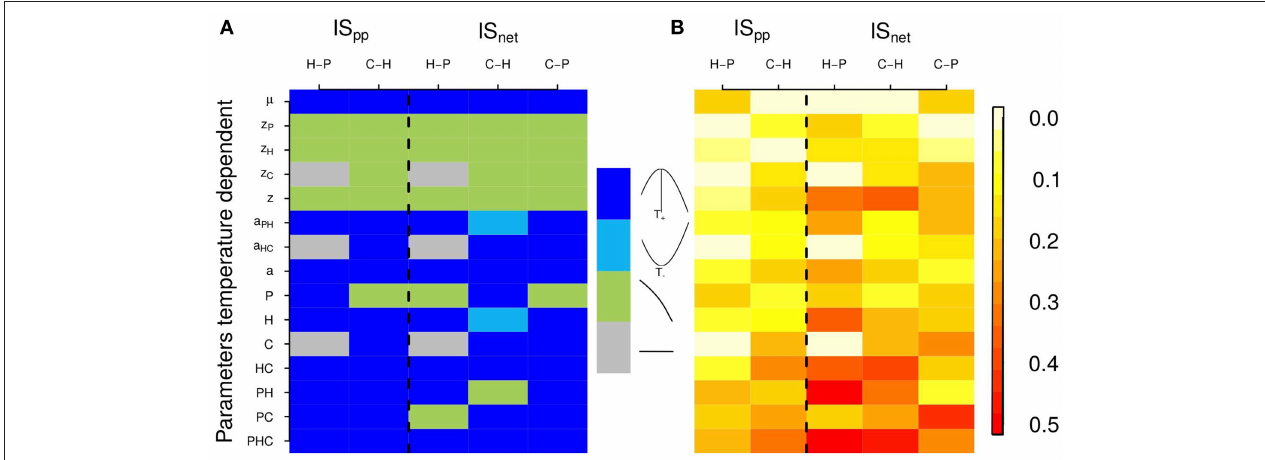
FIGURE 3 | Effects of temperature on two interaction strength measures: interaction strength per population, IS pp , and net interaction strength, IS net . Each column corresponds to different interactions between consumers and resources: H-P stands for the interaction between herbivores and primary producers in absence of carnivores, C-H for the interaction between carnivores and herbivores and C-P for the indirect interaction between carnivores and primary producers. (Note that to facilitate the comparison between those different interactions, we represented here the inverse of IS C − P . Hence, for all interactions, a hump-shaped relationship means that IS first increases with temperature and a U-shaped relationship means that IS first decreases with temperature.) Each row corresponds to a different scenario of thermal dependence of parameters. Parameters that vary with temperature are specified on the left of the plot (e.g., second row: only z P , the primary producer mortality rate, varies with temperature, other parameters being fixed). When the subscript is not indicated, biological rates of every trophic levels vary with temperature (e.g., 5th row: z , mortality rates of primary producers, herbivores and carnivores vary with temperature). When the trophic level is indicated (P, H and/or C), the parameters of the given trophic level(s) vary with temperature (e.g., 9th row: primary producer parameters, µ and z p , vary with temperature). Hence for the last row (PHC), all parameters vary with temperature. Fixed parameters are set at their optimal value. (A) Qualitative representation of the shape of the thermal response of IS measures for different scenarios of parameters temperature dependence (as in Figure 2 ). The shapes of the thermal dependence of interaction strength are color coded; see color key, dark blue: hump-shaped, light blue: U-shaped, light green: decrease and gray: no temperature dependence. (In the last case, gray cells, there is no effect of temperature because all parameters are fixed for those interactions. Indeed, here the interactions between primary producers and herbivores are independent of carnivore’s biological rates). (B) Thermal sensitivity of interaction strength for different scenarios of parameters temperature dependence, quantified as the standard deviation of interaction strength measures (color coded, see color